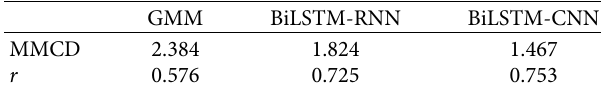
Table 3: The MMCD (dB) and r on the test set when using GMM, BiLSTM-RNN, and BiLSTM-CNN for EMA-to-MFCC conversion.